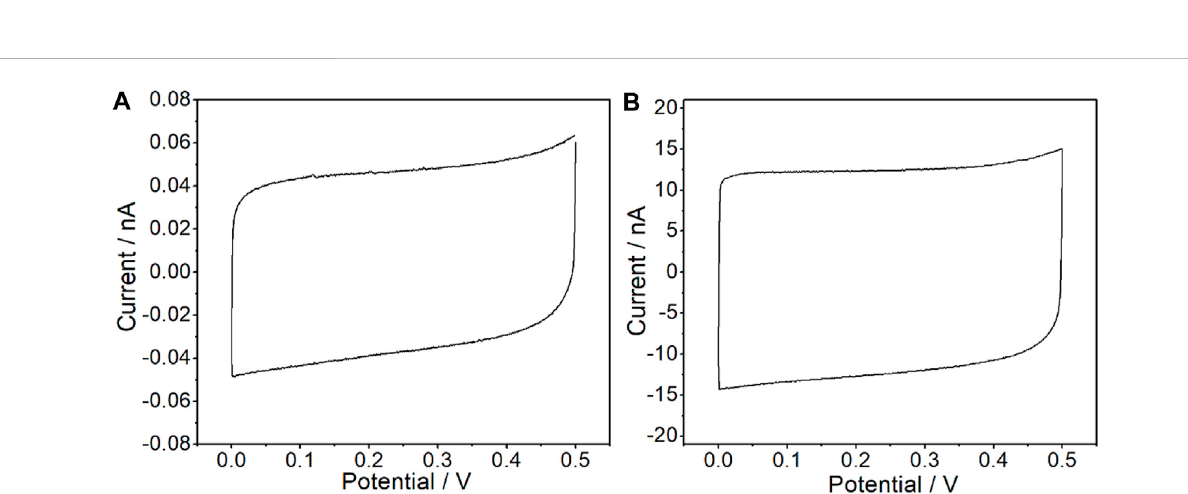
(PSS). As shown in Figure 3A, a high reversibility for the doping process of the PEDOT (PSS) fi lm could be revealed from a capacitive process with a symmetrical near-rectangular shape of the CV from 0 to 0.5 V (Ocaña et al., 2018). The capacitive current of the CF μ Es was only at the 4 × 10 − 11 A level because of the high resistance, while the CF μ E/PEDOT (PSS) was 200-fold higher than the bare microelectrode (Figure 3B). This phenomenon indicates that the redox capacitance of the electrode could be enhanced due to the presence of the PEDOT (PSS) fi lm, which is in accordance with the conventional electrode (Yin et al., 2012). In order to calculate the effective surface area of the CF μ E, CV was carried out in 5 mM [Fe (CN) 6 ] 3-/4- solution in the background of 0.1 M KCl (Supplementary Figure S2). According to the Randles – Sevcik equation: ip = 2.69 × 10 5 n 3/2 A D 1/2 V 1/2 C o , where ip is the peak current (A), n is the number of electrons, A is the electrode area, D is the diffusion coef fi cient 6.7 × 10 − 6 (cm 2 S − 1 ), V is the scan rate (V s − 1 ), and C o is the concentration (mol cm − 3 ) (Rizwan et al., 2018). The effective surface area of the CF μ E was calculated to be 8.9 × 10 − 11 cm 2 , and the effective surface area of the electrode increased to 15.5 × 10 − 11 cm 2 after the modi fi cation of the PEDOT (PSS) fi lm.